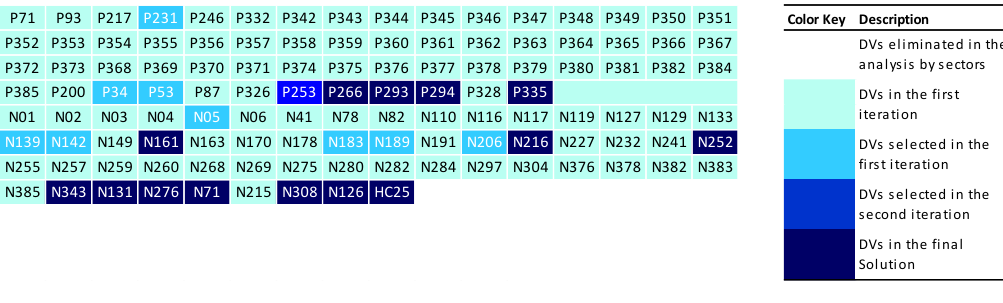
Figure 13. SSR in the ES-N network. Table 4. Objective function of the best solution found for the ES-N network.